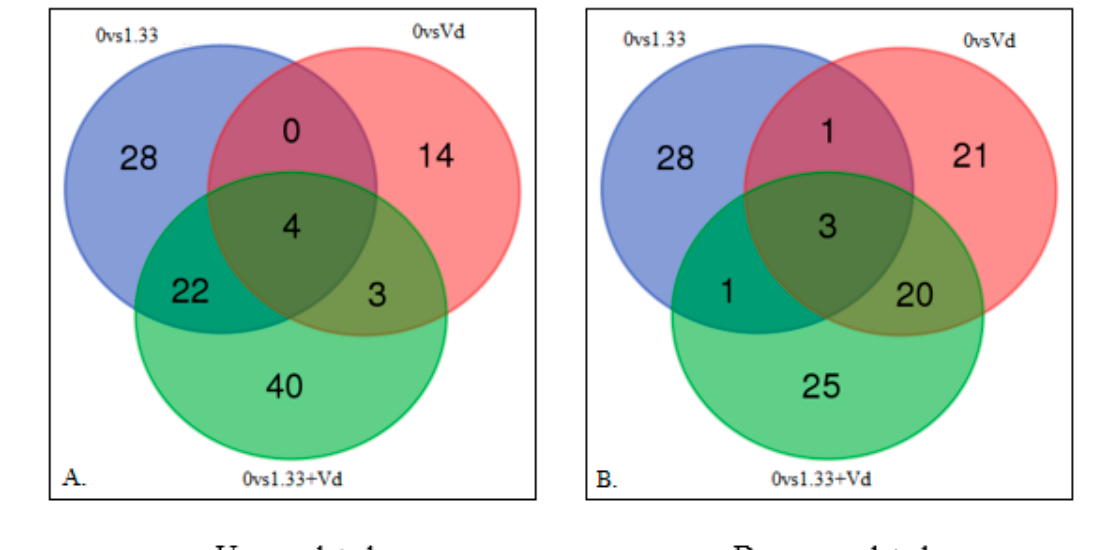
Figure 2. Venn diagram showing number of DEGs based on the differential gene expression analysis, and the genes in common between the pairwise comparisons of 0 ng of clothianidin vs. 0.1.33 ng of clothianidin (0 vs. 0.1.33), 0 ng vs. 0 ng plus V. destructor (0 vs. Vd) and 0 ng vs. 1.33 ng of clothianidin plus V. destructor (0 vs. 1.33 + Vd). ( A ) Venn diagram showing the number of up-regulated DEGs ( B ) Venn diagram showing the number of down-regulated DEGs.